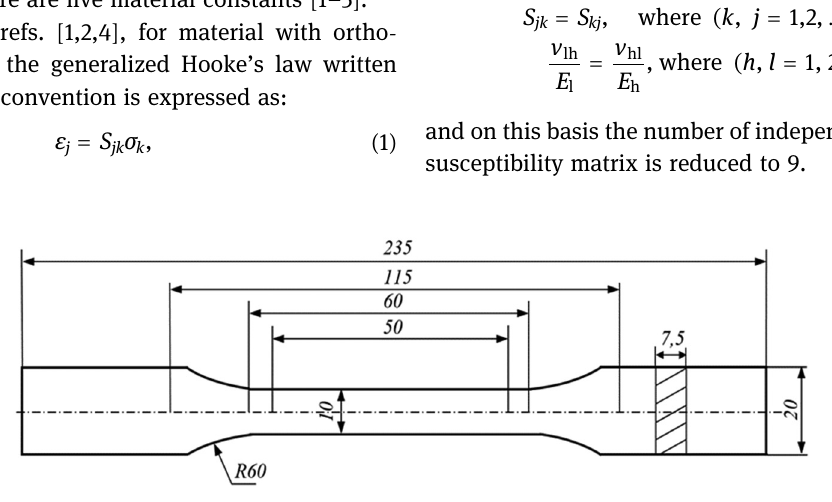
Figure 3: Shape and dimensions of test